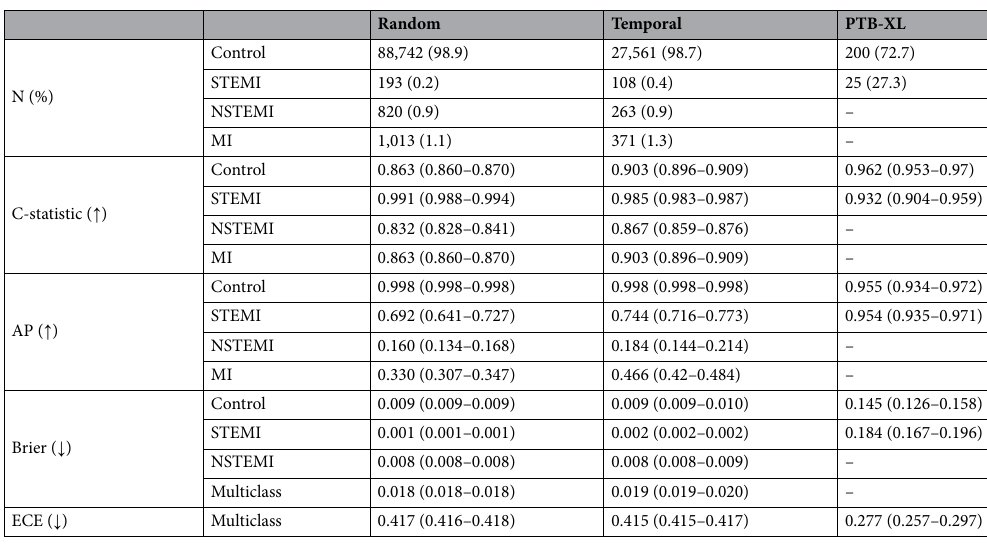
Table 2. Performance of the model in the random and temporal test set of the study sample as well as the external PTB-XL test set. Results of the model in the two study sample test sets and the publicly available PTB-XL dataset as comparison in the rightmost column. Sample size is given by each test set and outcome label together with proportion out of the given test set. Performance metrics are given as median (minimum– maximum) over ten trained models initiated with different seeds; each of the ten models is an ensemble consisting of five model members. Arrows indicate direction of better performance. We compute the metrics as class vs. all. Note that the class MI merges the classes STEMI and NSTEMI in one class. ECE is for multi-class calibration instead of class-wise calibration. STEMI, ST-elevation myocardial infarction; NSTEMI, non-ST- elevation myocardial infarction; AP, Average Precision or equivalently Area Under the Precision-Recall curve; ECE, Expected Calibration